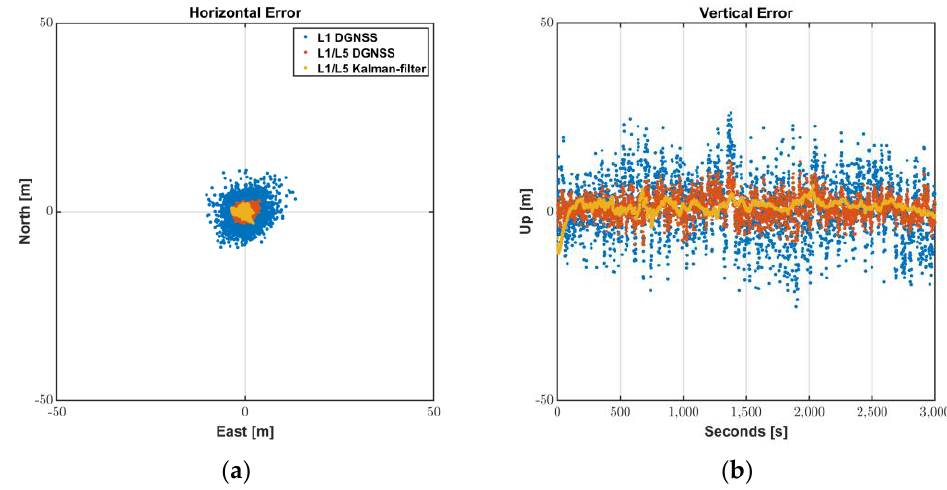
Figure 12. L1/L5 Kalman-filter positioning results: ( a ) Horizontal Error; ( b ) Vertical Error. Table 6. Statistics of L1/L5 Kalman-filter positioning